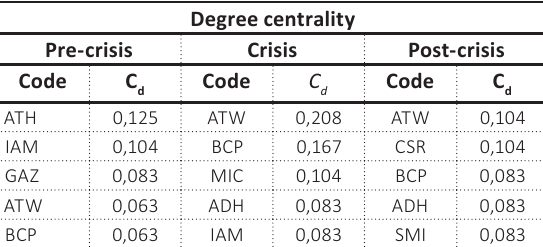
Table 5. The five highest values of degree centrality for the three periods